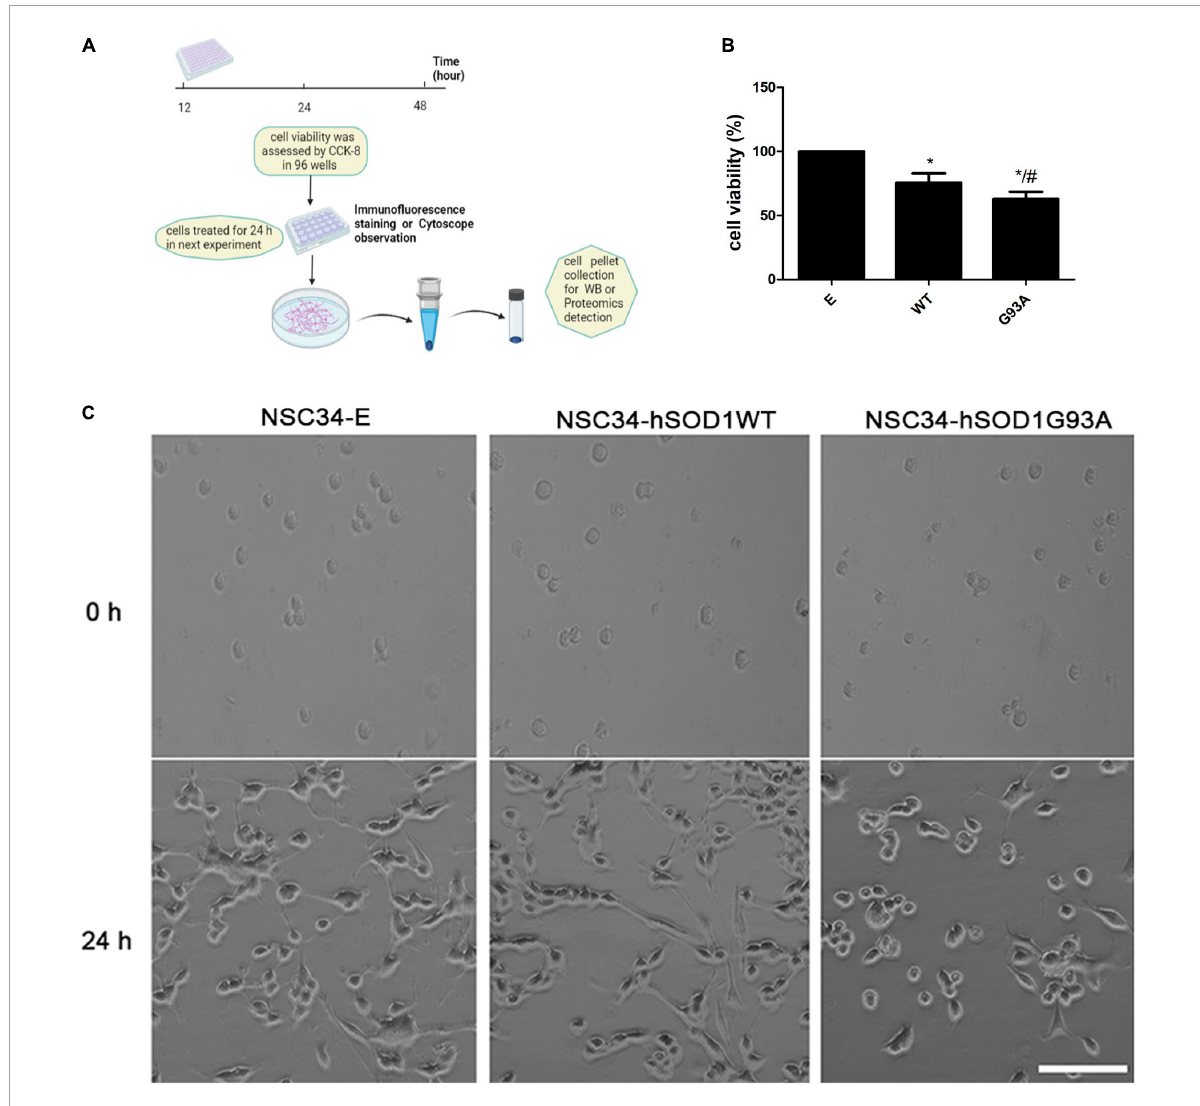
FIGURE3 NSC34-hSODG93A cells as the in vitro model of ALS. (A) Schematic overview of cell experiments. (B) Cell viability of NSC34-E, NSC34-hSOD1WT and NSC34-hSOD1G93A cells. (C) Cells were seeded in culture dishes, differentiated for additional 24 h and photographed by phase contrast microscopy. Data represent the mean ± SEM, statistical significance was assessed by one-way ANOVA followed by LSD- t test. *P < 0.05, vs . NSC34-E cells; # P < 0.05, NSC34-hSOD1WT cells vs . NSC34-hSOD1G93A cells. Bar = 100 µ